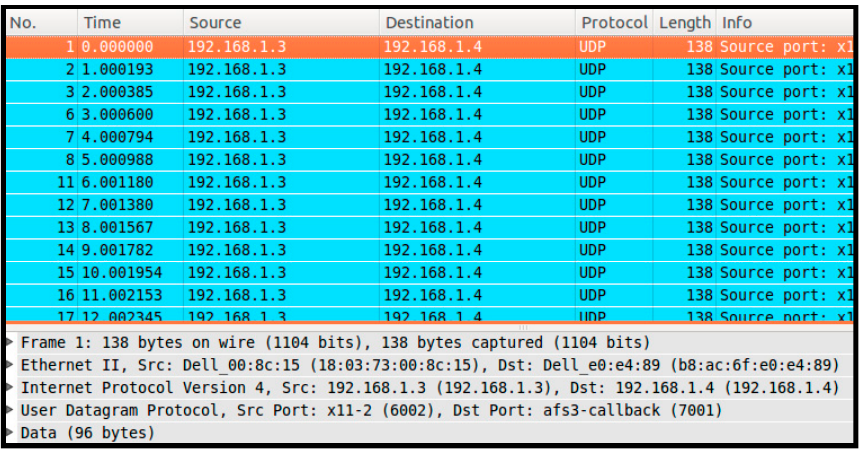
Figure 26. Packet capture (between the R ‐ GW and DMC).